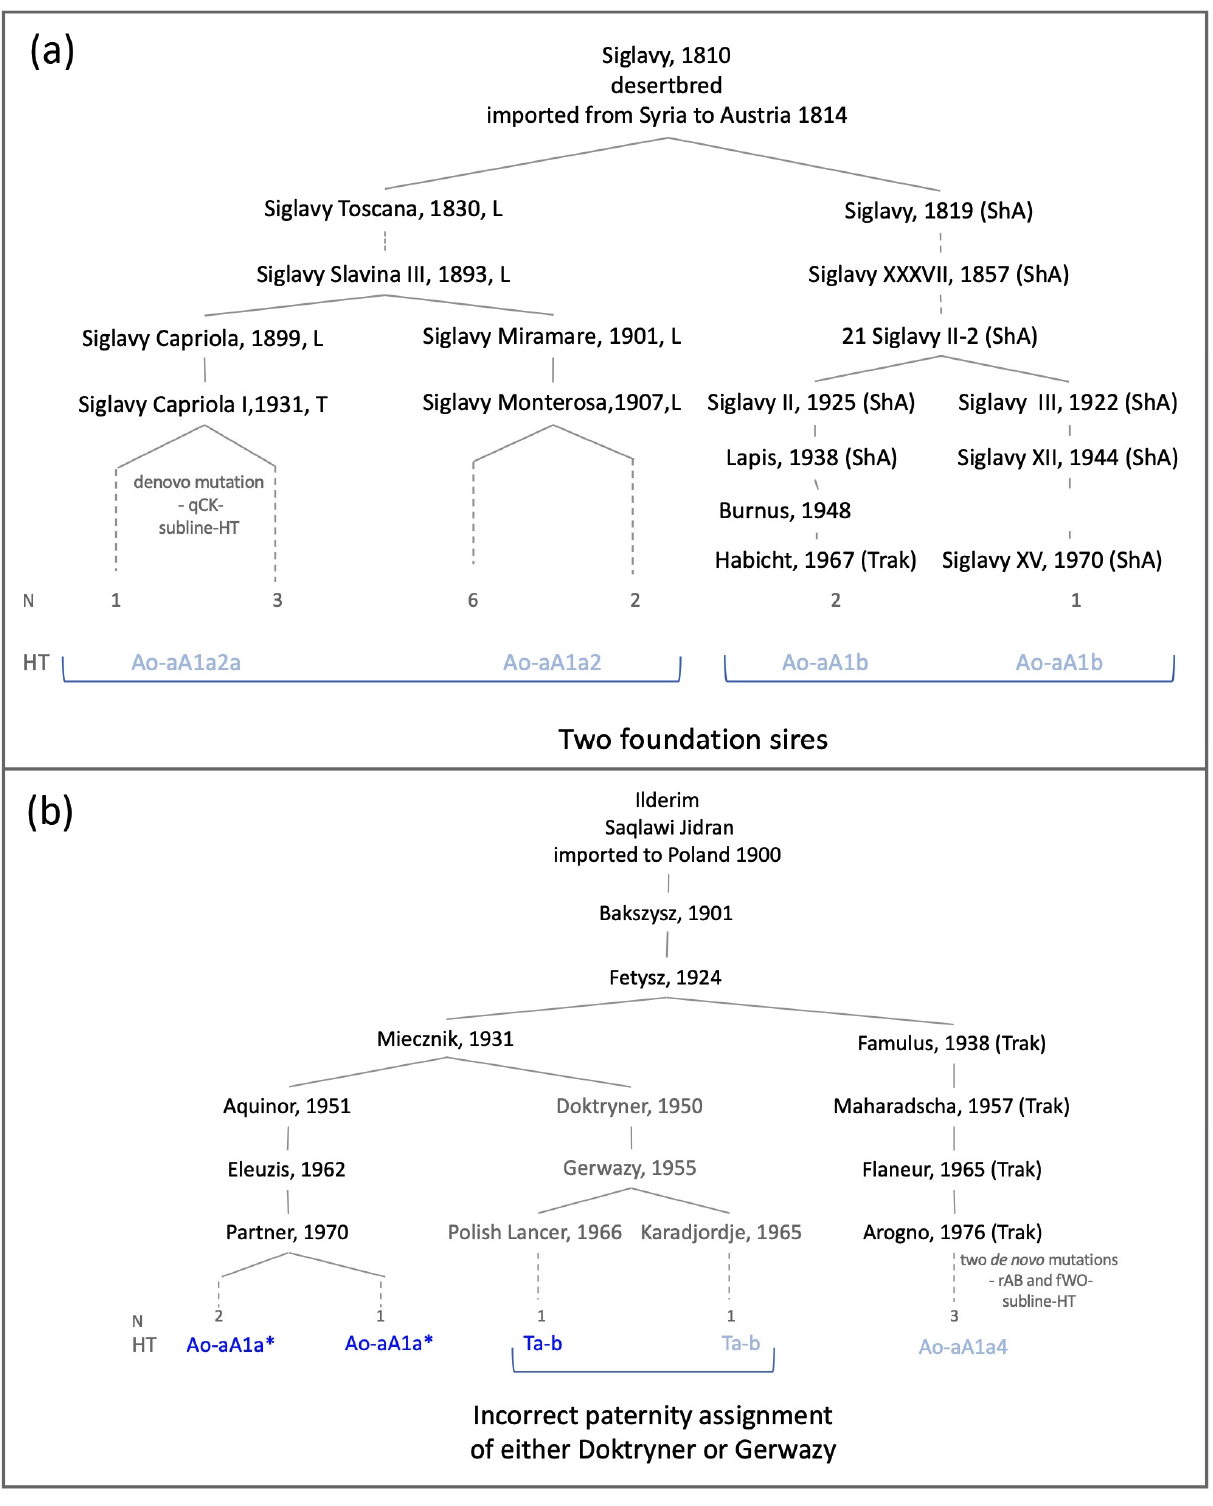
Figure 3. Genealogical cases. ( a ) Paternal genealogies of 15 genotyped male horses after Siglavy, 1810. ( b ) Paternal genealogies of eight genotyped male horses after Ilderim db. Dotted lines indicate that at least one generation is omitted. Abbreviation of horse breeds other than Arabian is given by: L = Lipizzaner, ShA = Shagya Arabian, Trak = Trakehner, AA = Anglo Arabian. The number of genotyped horses and HTs is listed on the bottom (dark HTs were detected in Arabians, light blue HTs in other breeds). The complete tail-male line reconstruction is provided in Table